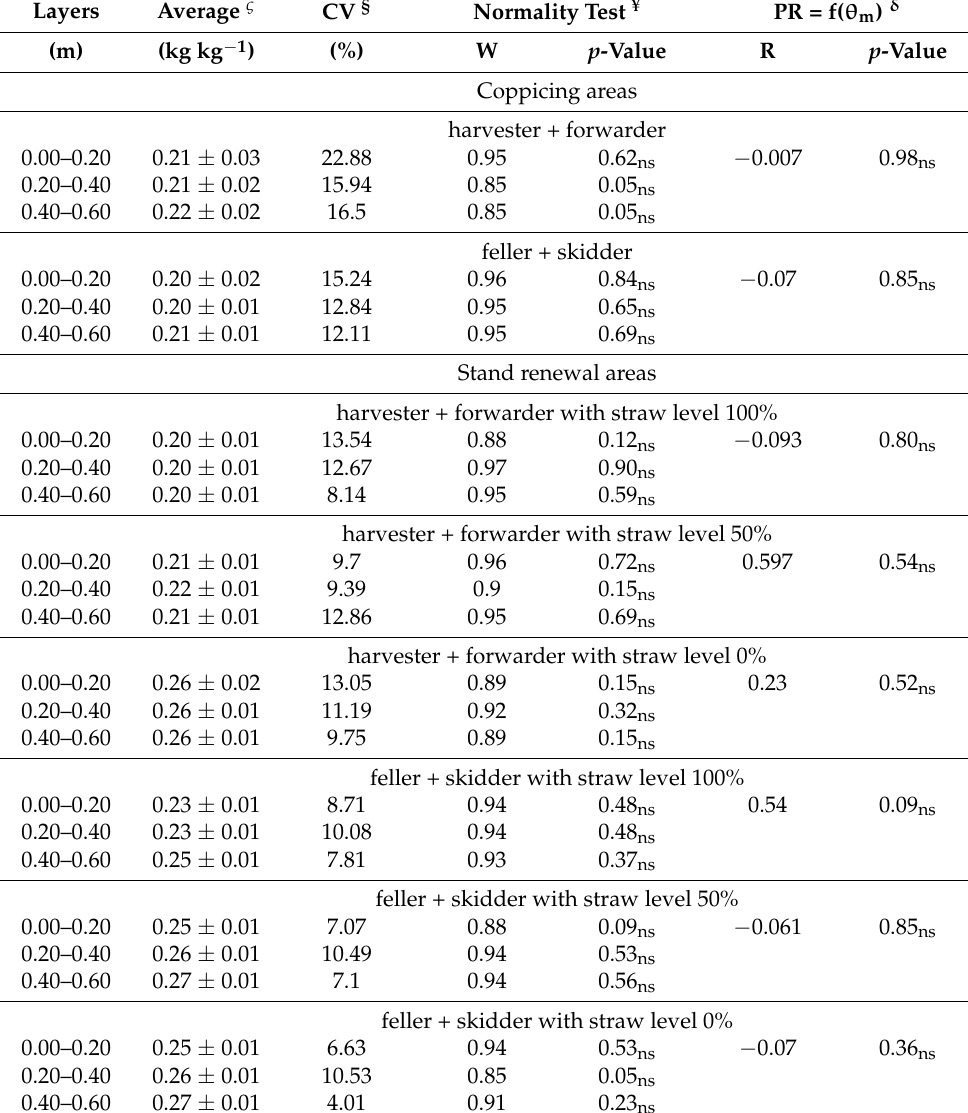
Table 2. Soil moisture averages ( θ m ) in the 0–0.20, 0.20–0.40 and 0.40–0.60 m layers, in eucalypt cultivation areas under coppicing and stand renewal with different straw levels (100, 50 and 0%), both harvested by harvester + forwarder (HF) and feller + skidder (FS) systems.